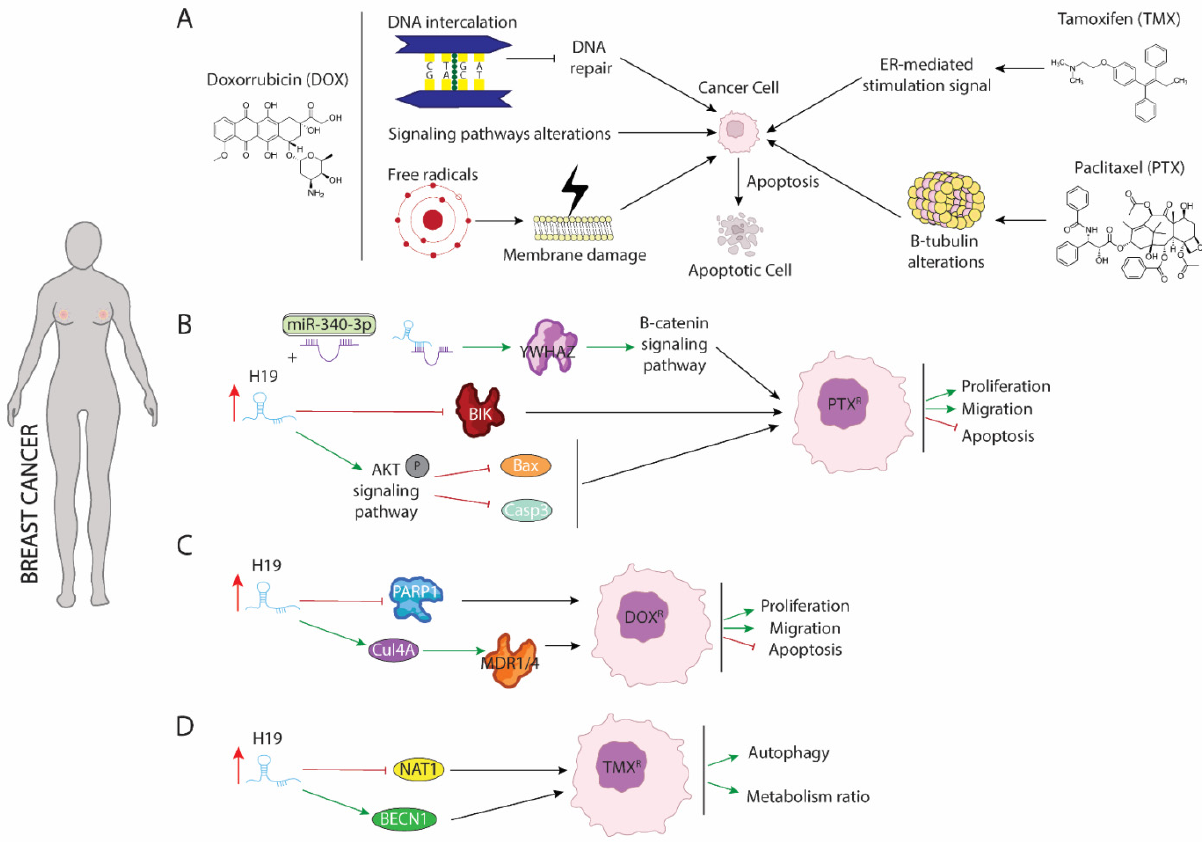
Figure 1. Schematic representation of molecular mechanism dependent of H19 function in breast cancer. ( A ) Modes of action of paclitaxel (PTX), doxorubicin (DOX), and tamoxifen (TMX) drugs involved in breast cancer treatment. ( B ) Role of H19 as a sponge to binding miR-340 enhancing expression of YWHAZ protein and increasing proliferation and migration while blocking apoptosis. ( C ) H19 increase expression of CUL4A and repress expression of PARP1 lead to DOX resistance in breast cancer. ( D ) H19 modulates methylation of BECN1 promotor and blocking NAT1 expression enhancing autophagy and metabolism procedures.